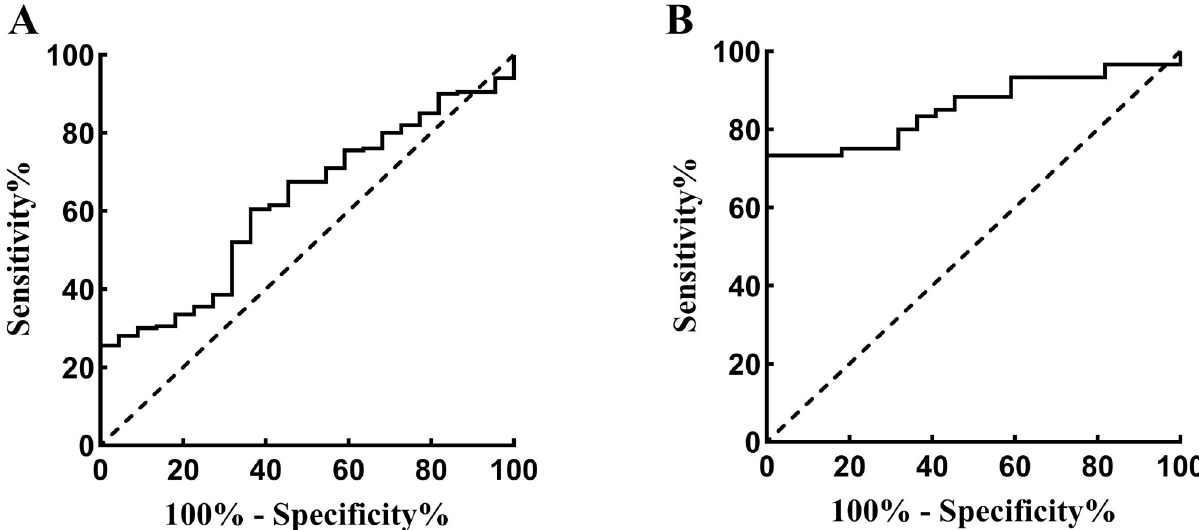
Fig 4. Receiver operating characteristic curve for evaluating epilepsy and refractory epilepsy by Fut8. A . Fut8 could distinguish the epilepsy patients from healthy controls with an AUC of 0.620. B. Fut8 could distinguish the refractory epilepsy patients from healthy controls with an AUC of